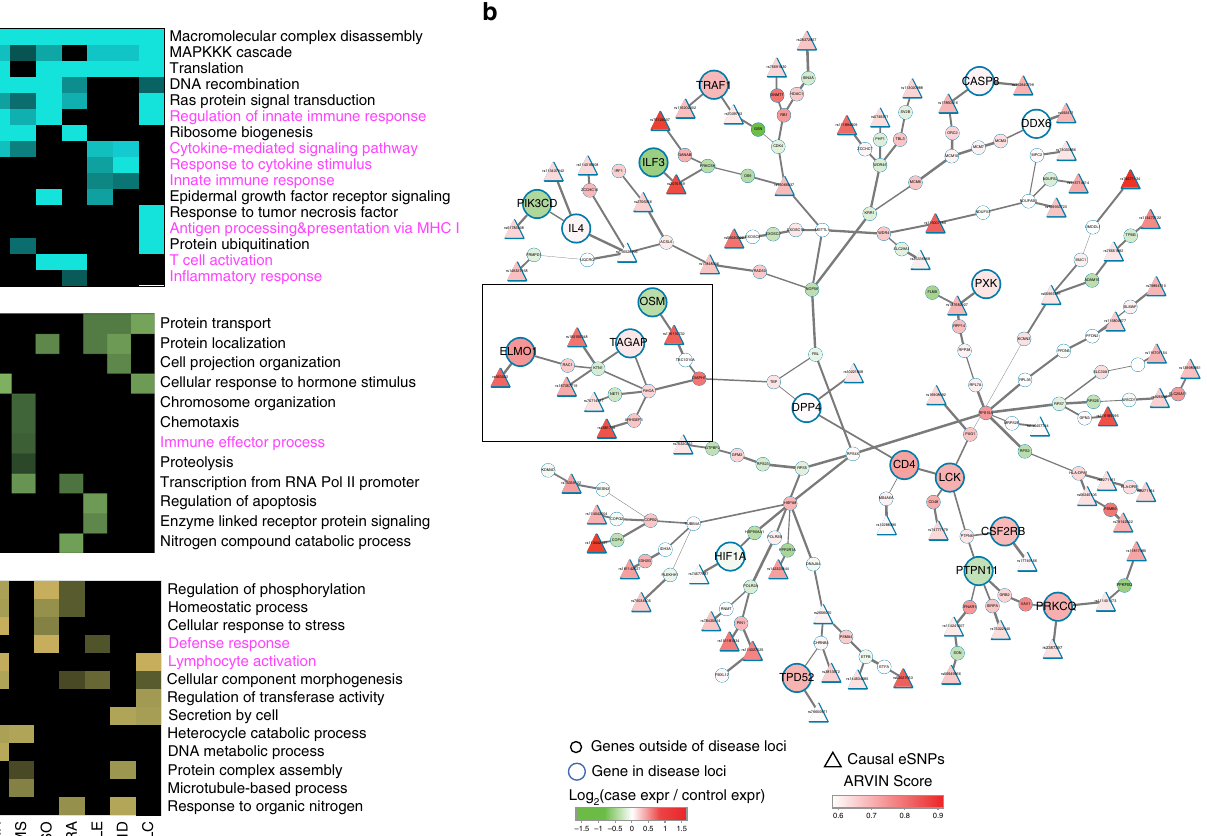
Fig. 7 Gene subnetwork collectively perturbed by all risk eSNPs in a disease. a Uniquely enriched GO terms among perturbed subnetworks downstream of risk eSNPs predicted by ARVIN (cyan), GWAVA (green), and FunSeq2 (yellow), respectively. GO terms for immune responses are highlighted in magenta. b An example of perturbed subnetwork by all risk eSNPs in rheumatoid arthritis. Circle, genes. Node size represents location of a gene relative to disease- associated loci; bigger node, within a disease-associated locus, smaller node, outside a disease-associated locus; node color represents differential gene expression between case and control samples. Triangle, predicted risk